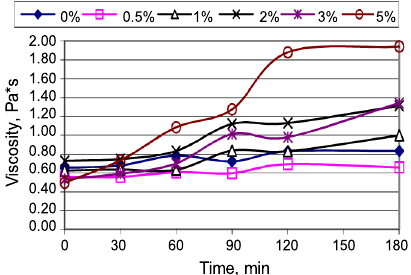
Fig. 15. Cement paste with CEM II N viscosity at shear rate 100 1/s (b) vs time after